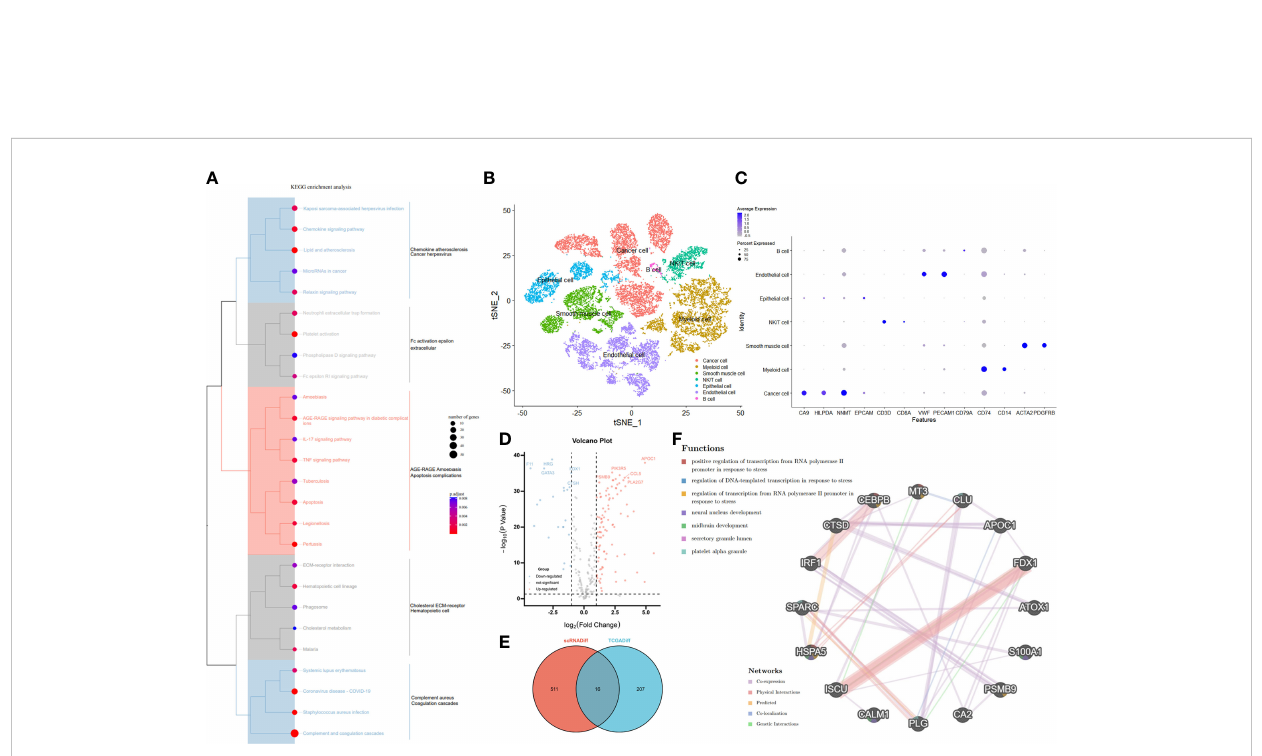
FIGURE 2 Identi fi cation and functional enrichment of differentially expressed CRGs. (A) The KEGG Tree enrichment plot of the 279 CRGs. (B) Reduced dimensional plots of tSNE for different cell types for single cell data. (C) Feature dot plots of different cell types for single cell data. (D) The Volcano map on differentially expressed CRGs in TCGA cohort. The fi ve most signi fi cant up- and down-regulated genes were labeled separately. (E) VENN plots of the same differential genes in the Single Cell sequencing and TCGA cohorts. (F) PPI network created by GeneMANIA showing the interactions of the CRG.